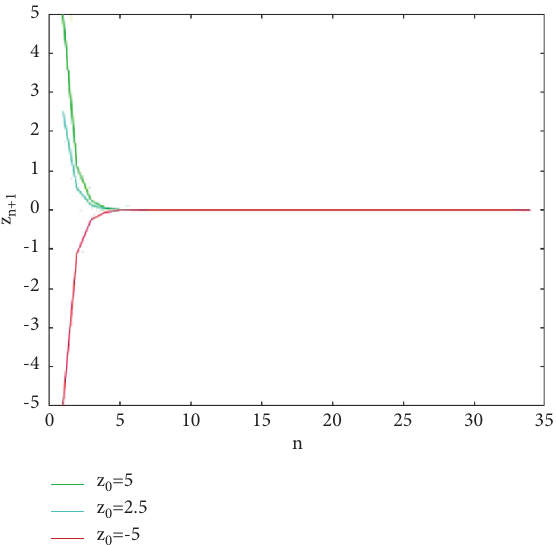
Figure 4: By combining all the above graphs, we get the following conjoining graph of convergence. Table 1: The values of z